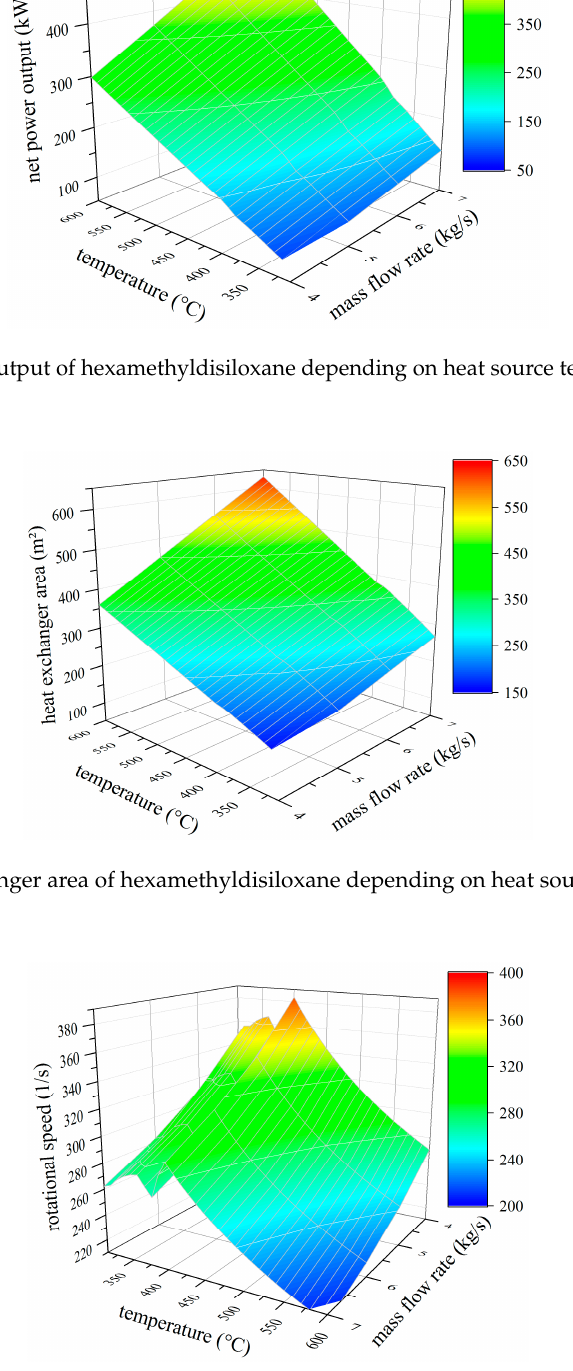
Figure 11. Turbine rotational speed of hexamethyldisiloxane depending on heat source temperature and mass flow rate.